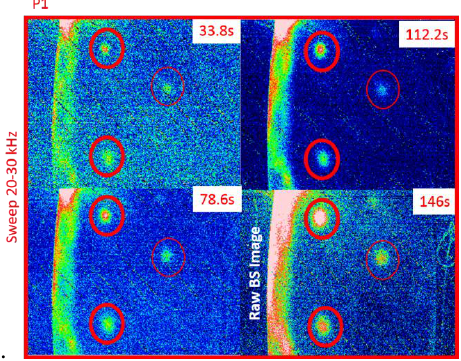
Figure 16. Nonlinear ultrasonic stimulated results thermography on a composite stiffened panel while conducting a sweep between 20 kHz and 30 kHz, with permission from 28 .